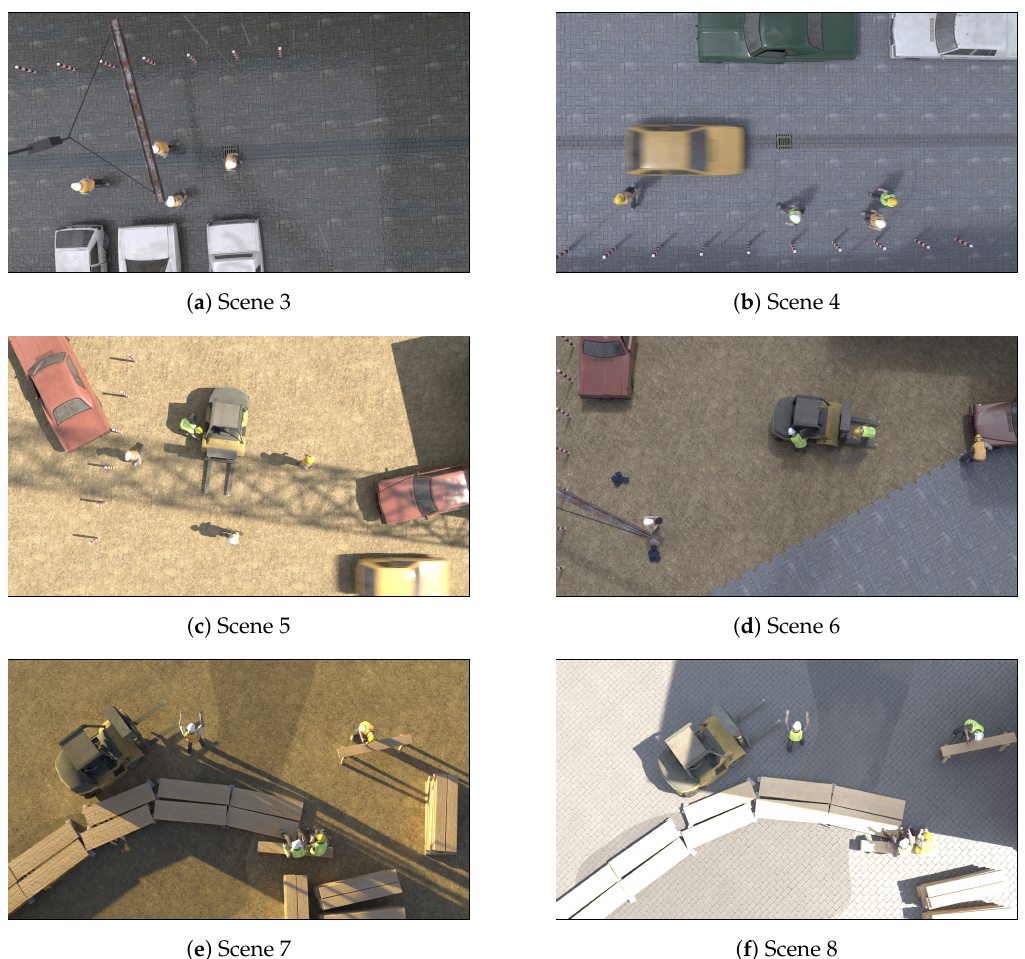
Figure 3. Synthetic scenes 3–8. See Table 1 for